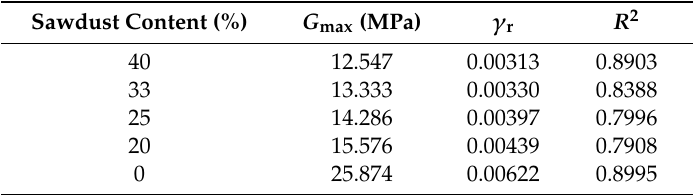
Table 4. Fitted maximum shear modulus and reference shear strain for various sawdust contents.